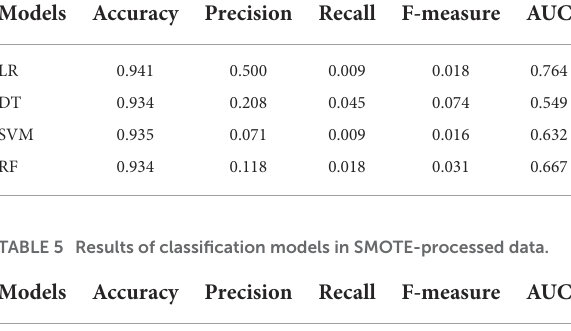
TABLE 4 Results of classification models in original unbalanced data.